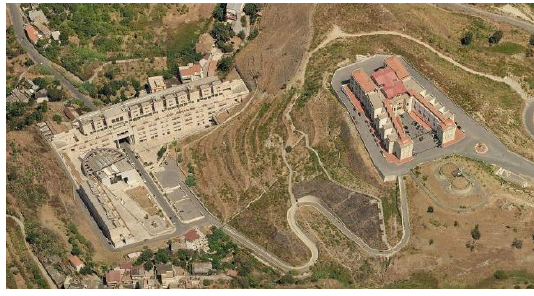
Figure 1. Aerial view of the area The aim of this work is to monitor and control the deformations of a part of the hill on which the Agrarian Department is located, Figure 2. This structure, after its construction, was affected by cracking and visible cracks, caused by